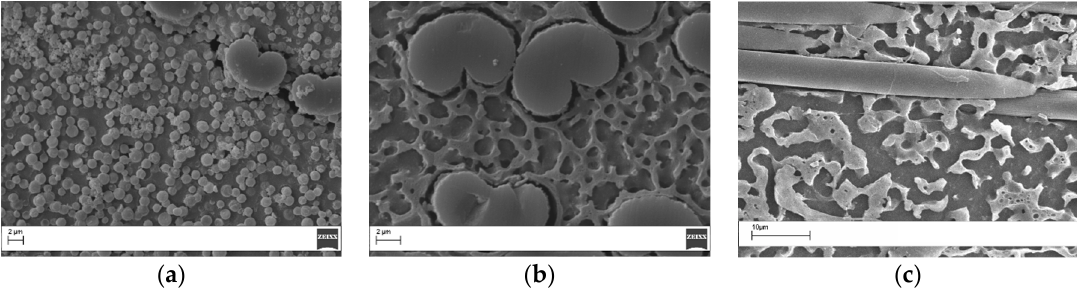
Figure 9. The interlaminar regions of the laminates modified with co-PES veils after post-curing: ( a , b ) magnification 10,000×; and ( c ) magnification 5000×.